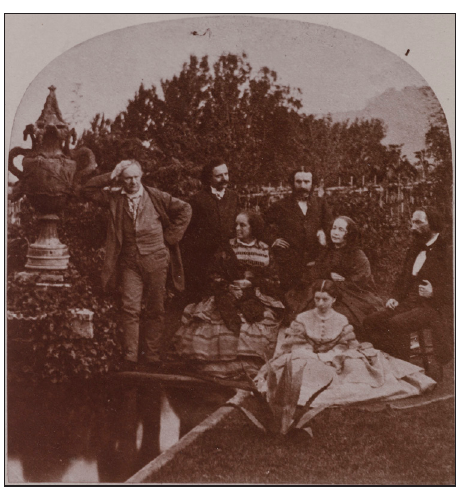
Fig. 3 : The Hugo family and friends in the garden of Hauteville House, c. 1860, photograph. CC0 Paris Musées/Maisons de Victor Hugo Paris-Guernesey.